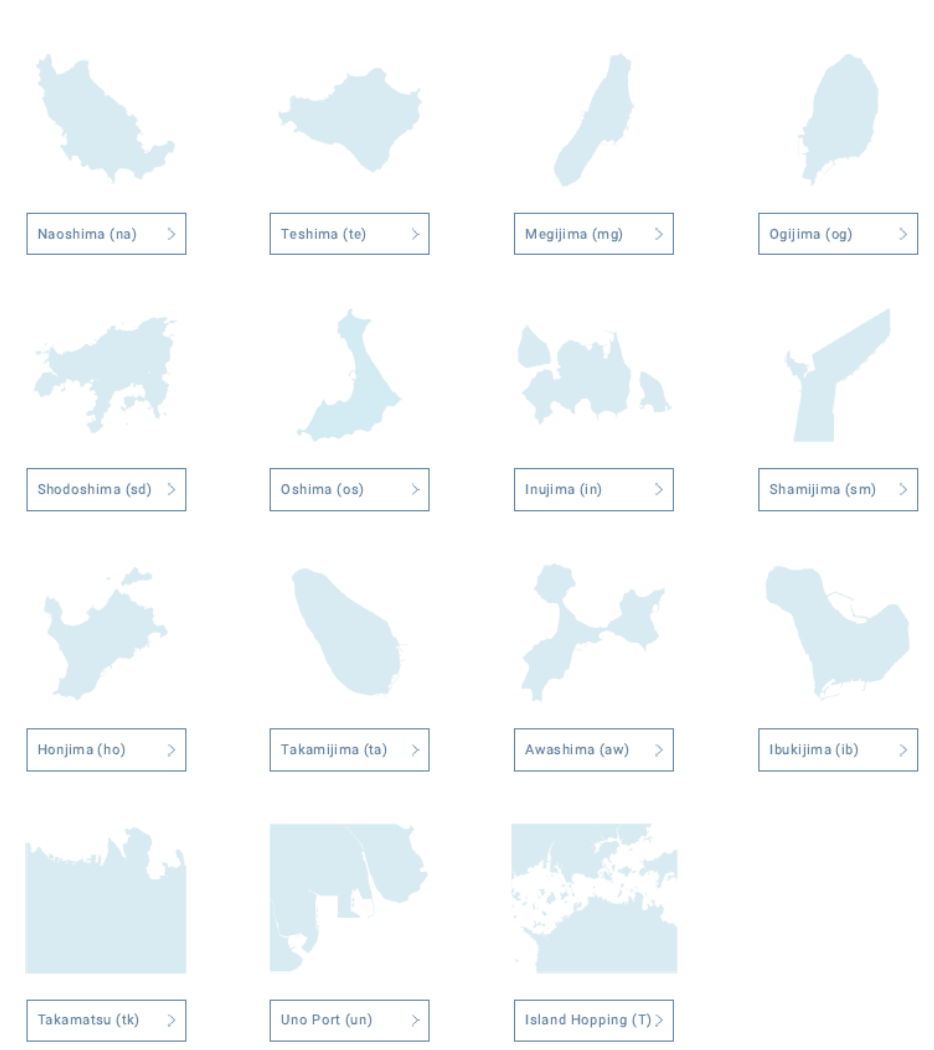
Figure 2. Pollution load of living environment items by cities in Japan 2018.